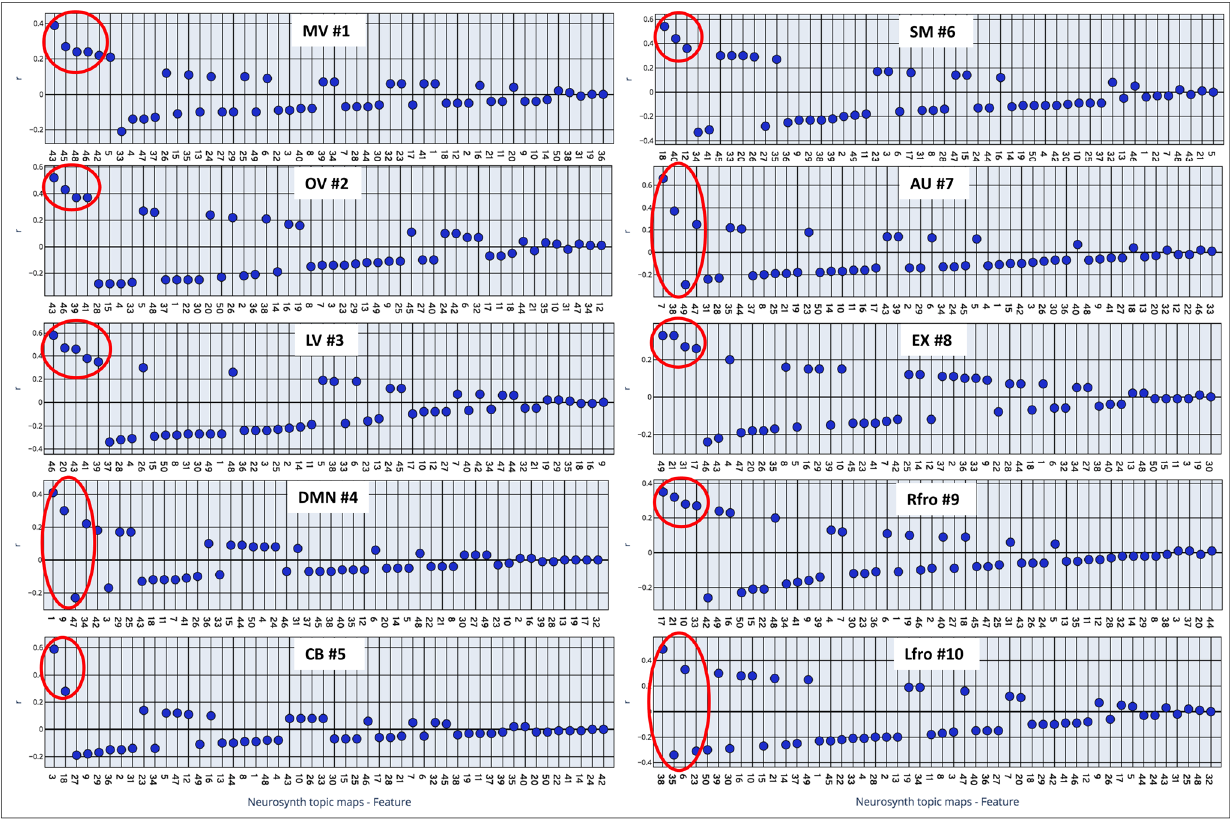
Fig. 8 Large-scale functional networks associated with neurosynth topic maps. The neurosynth topic-based meta-analyses (https://www.neurosynth. org/analyses/topics/) using standard topic modeling approach (Latent Dirichlet allocation — train a correlation decoder) to the abstracts or text of articles in the database revealed 50 topic maps. Each subplot represents a correlation between LDA 50 topic maps and the corresponding functional network. The X -axis shows the numbered topic maps in each subplot. The related names are separately listed in Supplementary Table 10. The Y -axis in each sub-plot depicts the decoded correlation with Smith-10 large-scale functional networks. The red circles indicate the highly correlated topics above > + 0.2. Figure 9 shows the topics within the red circles and their anatomical assignments within the